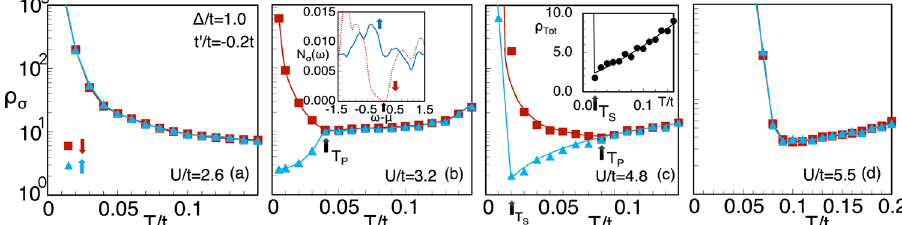
Fig. 1 Temperature evolution of spin-dependent transport. a – d Show spin-resolved resistivity, ρ σ ( T ) for correlation strength U values as indicated. ρ σ ( T ) is calculated in units of ( π e 2 / ℏ a 0 ), with e , ℏ and a 0 being the electronic charge, the Planck ’ s constant divided by 2 π and the lattice spacing respectively. The next nearest neighbor hopping t 0 = t and charge transfer energy Δ / t are chosen to be − 0.2 and 1.0, respectively. The squares denote ρ ↓ and triangles represent ρ ↑ . The inset in b shows the low T ( = 0.005 t ), spin-resolved density of states (DOS), N σ ( ω ) for U / t = 3.2, with a small arrow at the bottom indicating the Fermi energy. The up and down spin channels are also indicated by arrows. The inset in c shows the total resistivity ρ ( T ) for U / t = 4.8. d ρ σ ( T ) for the robust Mott insulator at U / t = 5.5. Results are shown for 32 2 system size with periodic boundary conditions. Standard deviation of the low- frequency optical conductivity data is used to estimate error bars in the resistivity plots. Symbol sizes used are larger than the error